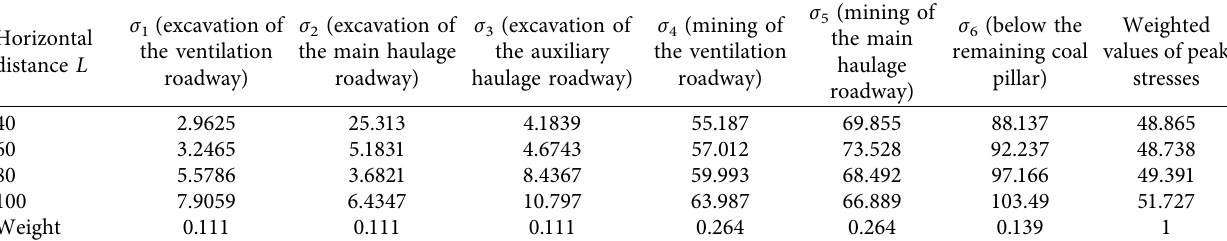
Table 3: Calculation of the optimal value of the horizontal distance L